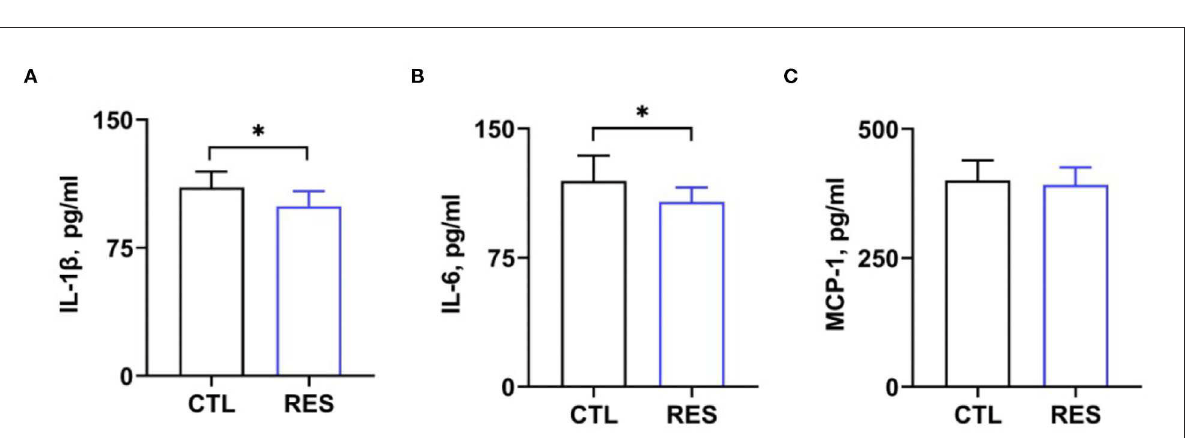
analysis with placental gene expression to better understand the role of the whole gut microbiota in regulating oxidative and inflammatory status. As shown in Figure 6A, a total number of 14 microbial genera were significantly correlated ( p < 0.05) with the placental nutrient transport, antioxidant defense, and inflammation-related mRNA expression.